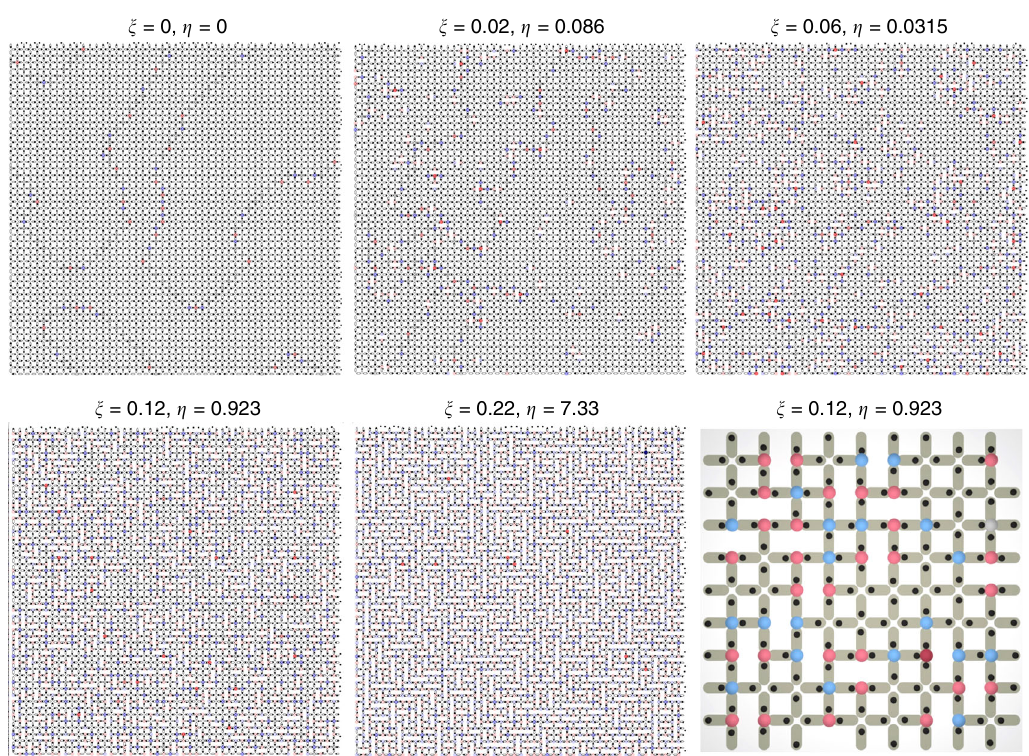
Fig. 4 Numerical results. Snapshots of numerical simulations for increasing decimation with color coding as in Fig. 2(b) indicating vertex charges. At zero decimation ( η = 0) large regions of the expected antiferromagnetic order separated by domain walls are visible. At low decimation of 2 – 6% ( η = 0.086, η = 0.315), almost all of the z = 3 vertices are positively charged, while negative charges ( q = − 2) that appear on the z = 4 vertices can pin the domain walls, causing the ordered domains to shrink. At a decimation of 12%, there is already no discernible order, while at high decimation, about half of the z = 4 vertices violate the ice rule and host positive charges, which destroy the remaining ordering. In the zoomed portion of the ξ = 12% and η = 0.923 sample, the colloidal positions are visible and show details of violation of the ice rule at z = 4 vertices by negative, q = − 2 monopoles only, but little or no ice rule violation at z = 3 vertices. See Supplementary Movies 3 – 6 for corresponding movie